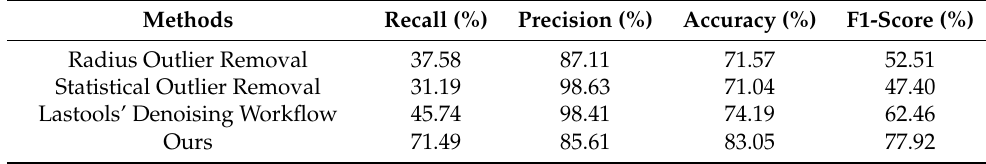
Figure 8. Examples of the denoising results in the mountain area. The four images in the upper right-hand corner show the profile line in the area of the red line on the left. The third row repre- sents the profile line partial details for convenient comparison. The fourth row indicates the DSM generated by the different denoising methods. The bottom row indicates some details of the DSM to facilitate comparison. Table 5. Performance evaluation of the compared approaches and ours in the water